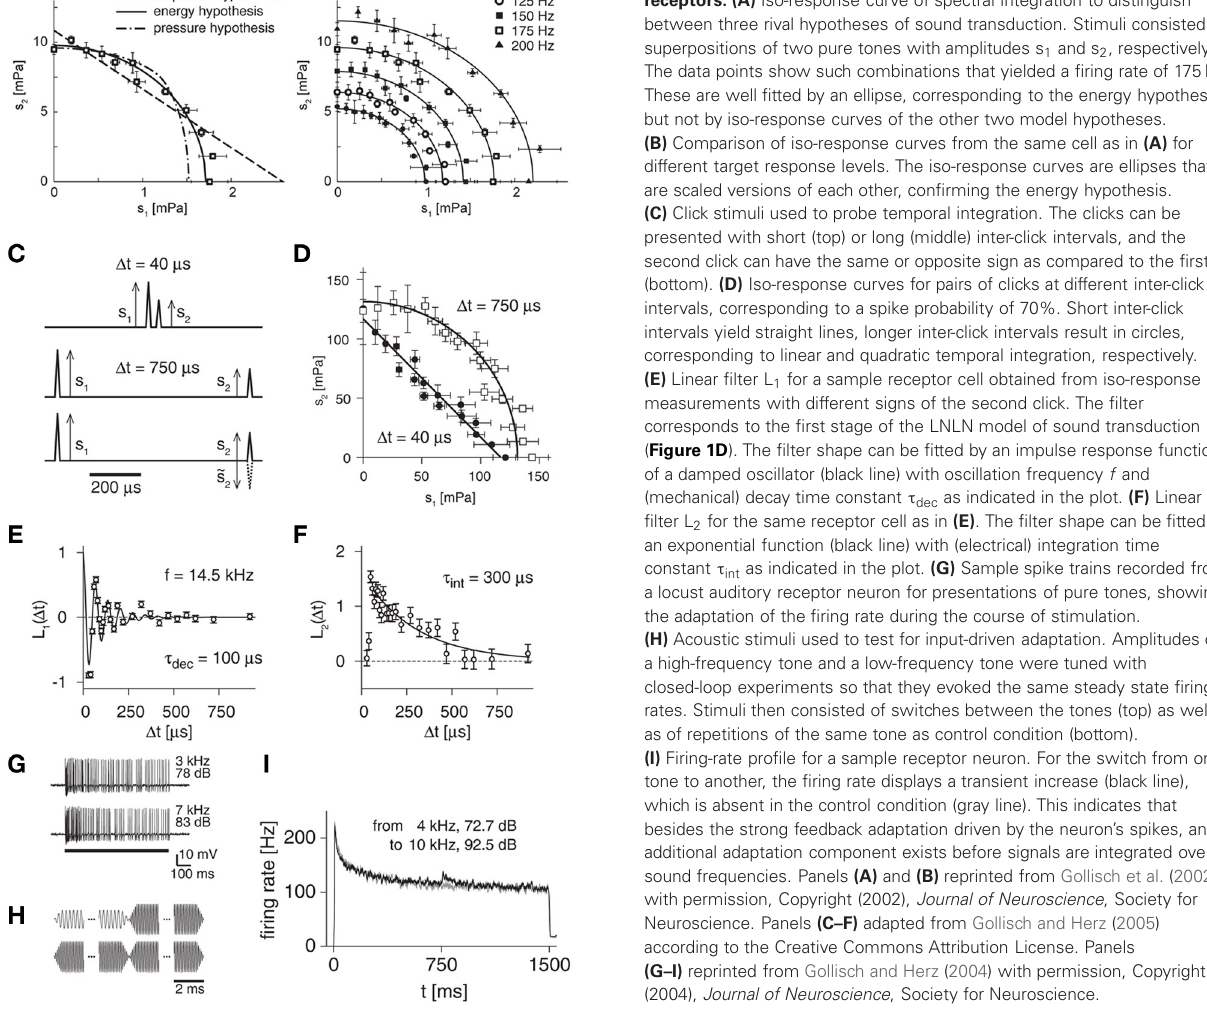
FIGURE 3 | Iso-response measurements for locust auditory receptors. (A) Iso-response curve of spectral integration to distinguish between three rival hypotheses of sound transduction. Stimuli consisted of superpositions of two pure tones with amplitudes s 1 and s 2 , respectively. The data points show such combinations that yielded a firing rate of 175Hz. These are well fitted by an ellipse, corresponding to the energy hypothesis, but not by iso-response curves of the other two model hypotheses. (B) Comparison of iso-response curves from the same cell as in (A) for different target response levels. The iso-response curves are ellipses that are scaled versions of each other, confirming the energy hypothesis. (C) Click stimuli used to probe temporal integration. The clicks can be presented with short (top) or long (middle) inter-click intervals, and the second click can have the same or opposite sign as compared to the first (bottom). (D) Iso-response curves for pairs of clicks at different inter-click intervals, corresponding to a spike probability of 70%. Short inter-click intervals yield straight lines, longer inter-click intervals result in circles, corresponding to linear and quadratic temporal integration, respectively. (E) Linear filter L 1 for a sample receptor cell obtained from iso-response measurements with different signs of the second click. The filter corresponds to the first stage of the LNLN model of sound transduction ( Figure 1D ). The filter shape can be fitted by an impulse response function of a damped oscillator (black line) with oscillation frequency f and (mechanical) decay time constant τ dec as indicated in the plot. (F) Linear filter L 2 for the same receptor cell as in (E) . The filter shape can be fitted by an exponential function (black line) with (electrical) integration time constant τ int as indicated in the plot. (G) Sample spike trains recorded from a locust auditory receptor neuron for presentations of pure tones, showing the adaptation of the firing rate during the course of stimulation. (H) Acoustic stimuli used to test for input-driven adaptation. Amplitudes of a high-frequency tone and a low-frequency tone were tuned with closed-loop experiments so that they evoked the same steady state firing rates. Stimuli then consisted of switches between the tones (top) as well as of repetitions of the same tone as control condition (bottom). (I) Firing-rate profile for a sample receptor neuron. For the switch from one tone to another, the firing rate displays a transient increase (black line), which is absent in the control condition (gray line). This indicates that besides the strong feedback adaptation driven by the neuron’s spikes, an additional adaptation component exists before signals are integrated over sound frequencies. Panels (A) and (B) reprinted from Gollisch et al. (2002) with permission, Copyright (2002), Journal of Neuroscience , Society for Neuroscience. Panels (C–F) adapted from Gollisch and Herz (2005) according to the Creative Commons Attribution License. Panels (G–I) reprinted from Gollisch and Herz (2004) with permission, Copyright (2004), Journal of Neuroscience , Society for